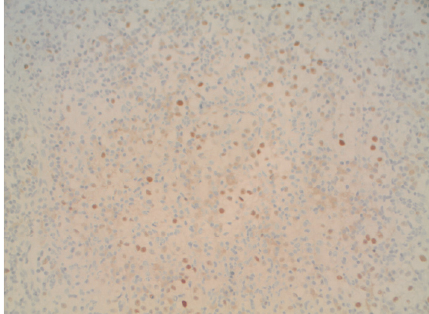
Figure 3: Positive immunohistochemical staining for PAX-2, con- sistent with clear cell